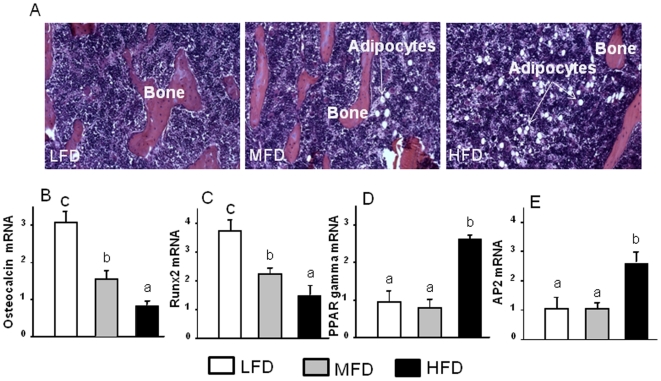
Increased adipogenesis in bone and bone marrow in HFD-induced obese animals.(A), Represented H&E staining picture of increased bone marrow adiposity in tibial bone section from HFD-induced obese animals (10x). (B) and (C), osteocalcin and Runx2 gene expression measured using real-time RT-PCR. (D) and (E), PPARγ and aP2 gene expression measured using real time RT-PCR. Total RNA was isolated from femur of each animal after bone marrow aspiration for RT-PCR. LFD, low fat diet (control pelleted AIN-93G 14% fat diet); MFD, medium fat diet (25% fat diet); HFD, high fat TEN diet (45% fat diet). Data bars are expressed as mean ± SEM (n = 6/group). Means with different letters differ significantly from each other at p<0.05, a<b<c as determined by two-way ANOVA followed by Student-Newman-Keuls post hoc analysis for multiple pairwise comparisons.